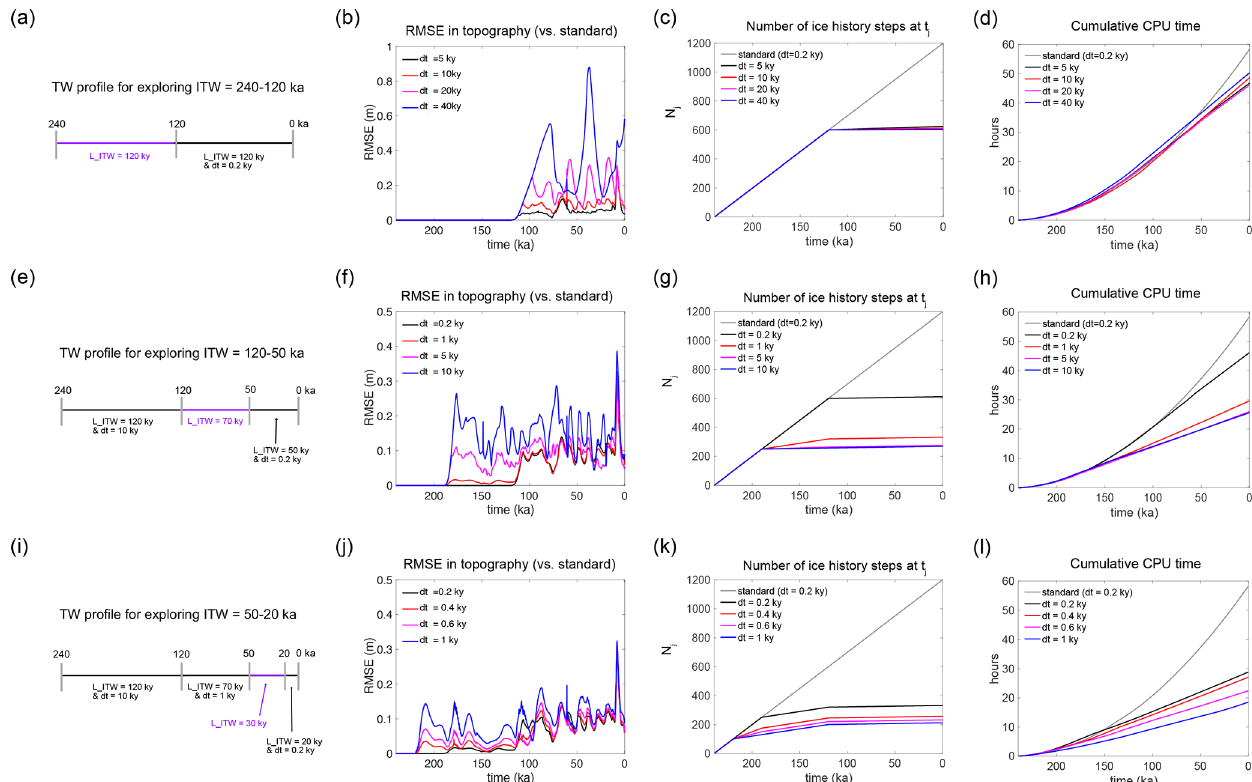
Figure 5. Time window profiles, RMSE in predicted topography, the number of loading events considered at t j ( N j ) and the total CPU times it has taken for the sea-level model to perform calculations at time step t j in the global simulations through the last 240kyr. Results from the simulations in which we explore the internal time windows that cover the periods between (a–d) 240–120ka, (e–j) 120–50ka and (i–l) 50–20ka. Note that the benchmark simulation assigns a uniform time-step size of 0.2kyr throughout the